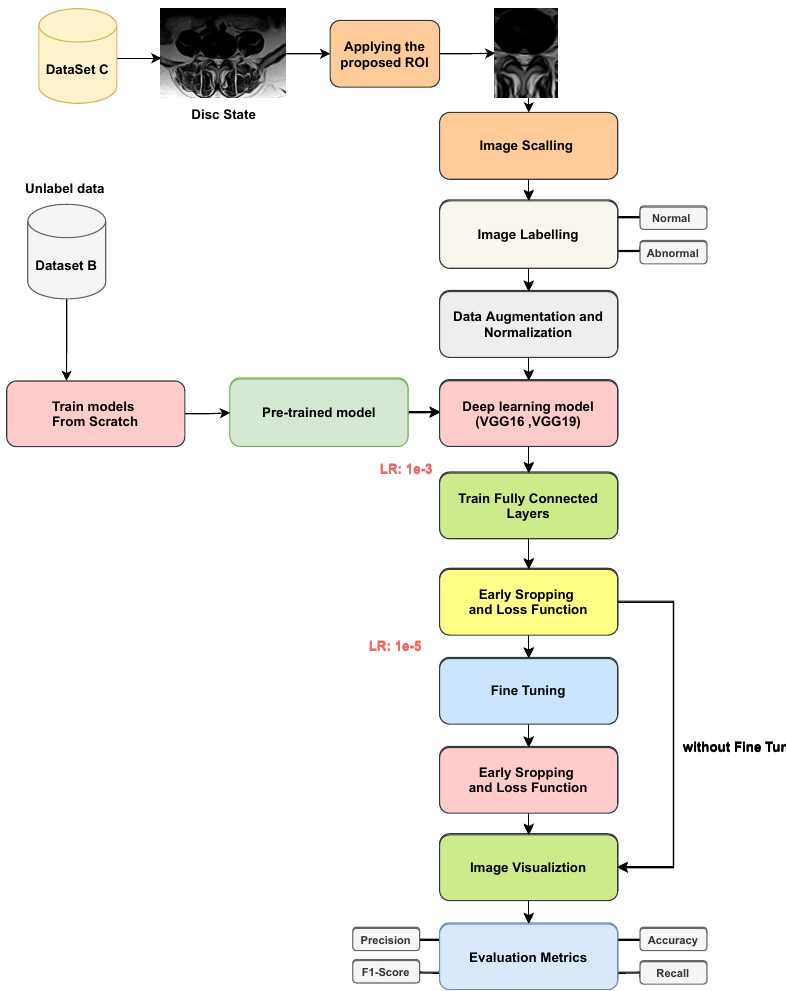
Figure 16. Transfer learning for disc state classification from unlabeled Dataset